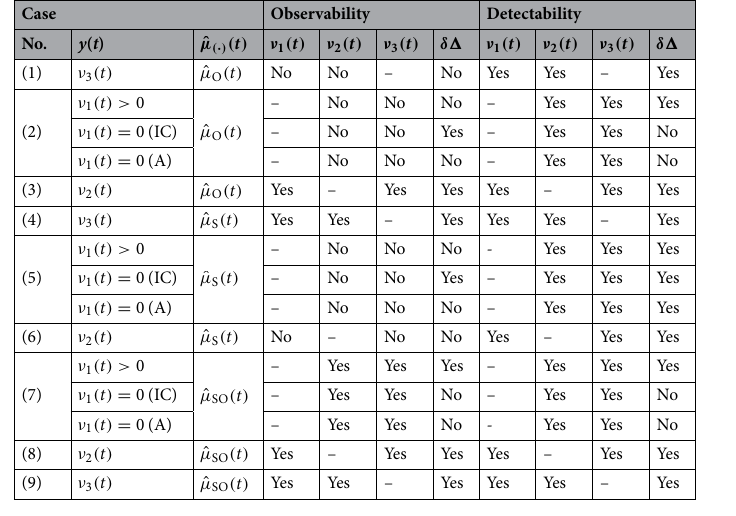
Table 2. Results of analysis based on indistinguishable dynamics with the